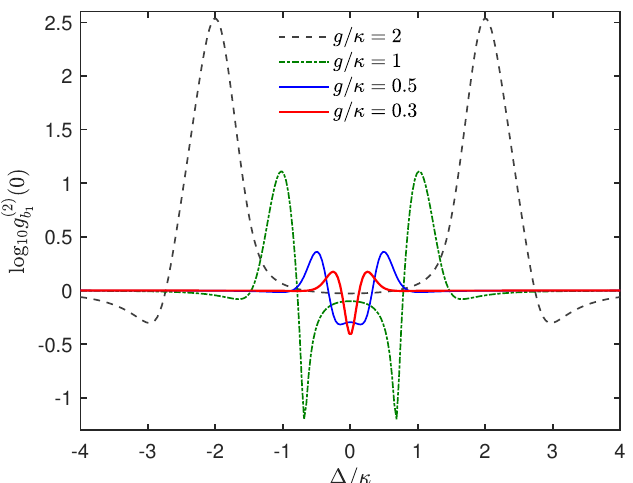
( 2 ) ( 0 ) of the SAW mode b b 1 = 0.05 κ , n = th 1